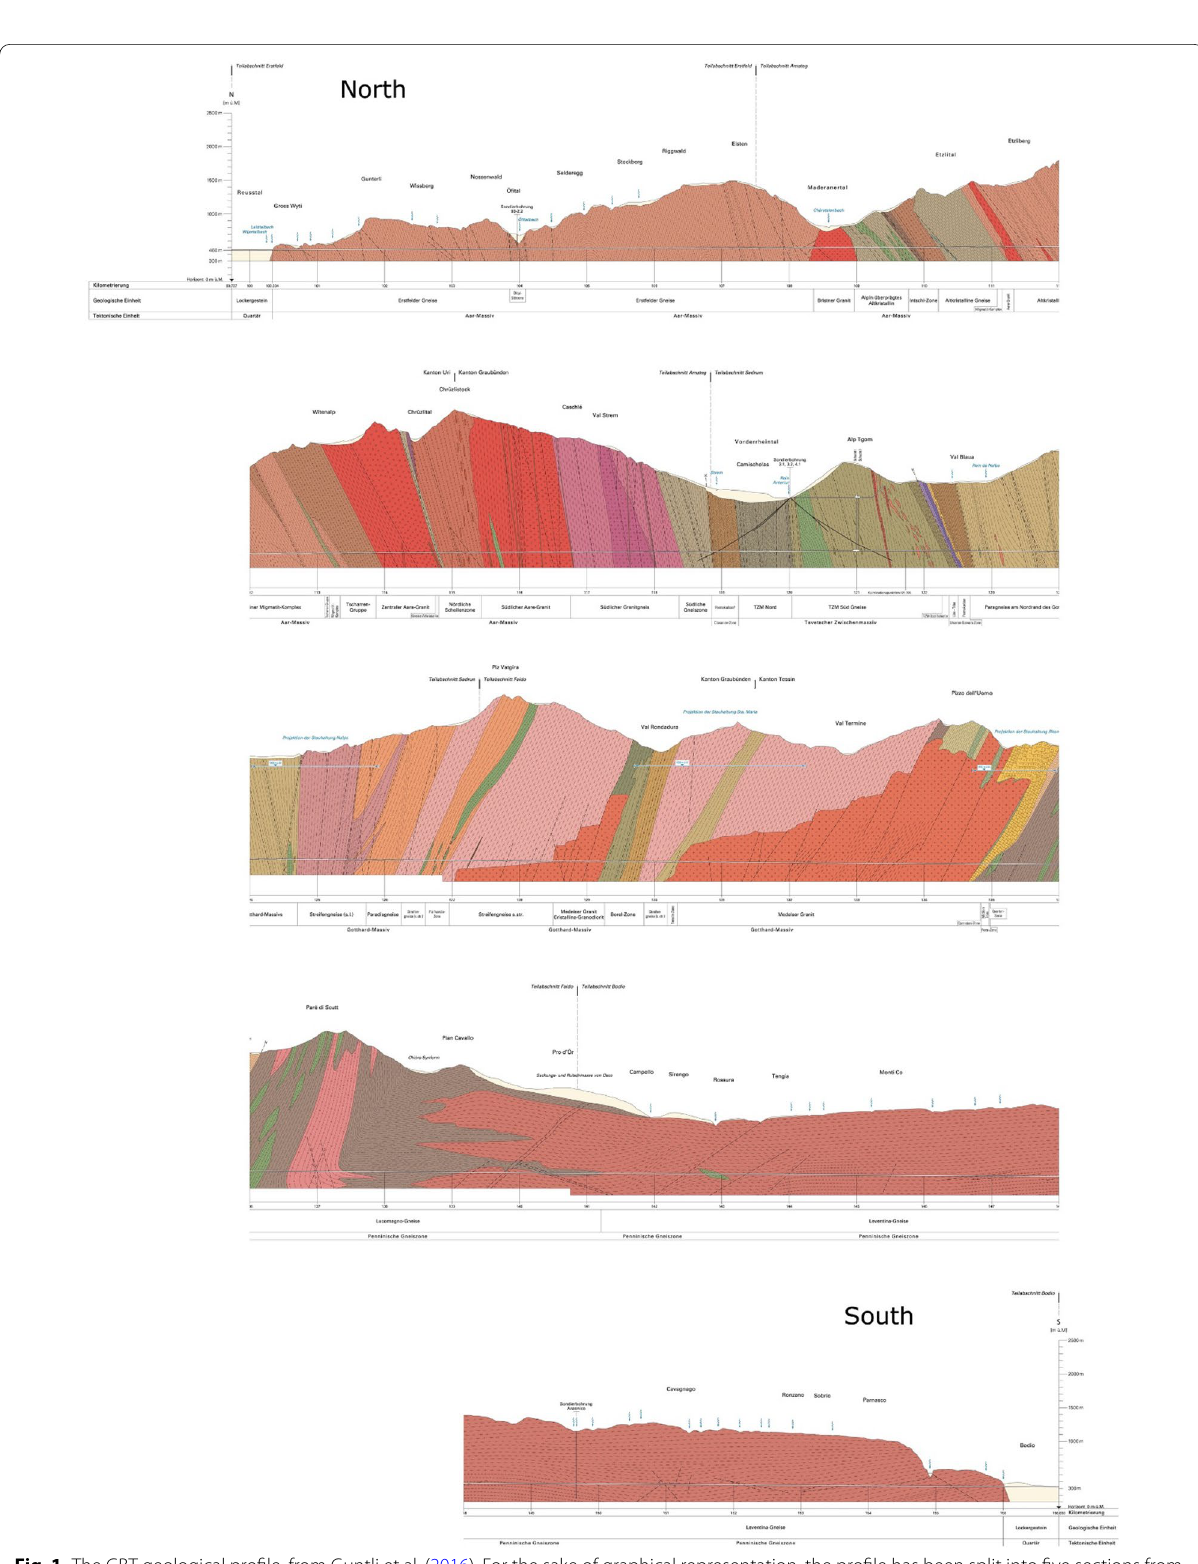
Fig. 1 The GBT geological profile, from Guntli et al. (2016). For the sake of graphical representation, the profile has been split into five sections from North to South. The associated legend, describing all the units, is reported in Guntli et al. (2016) in paper format